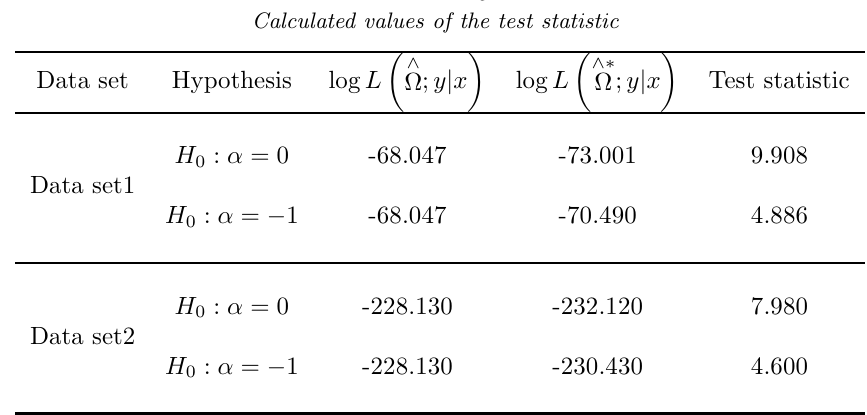
Calculated values of the test